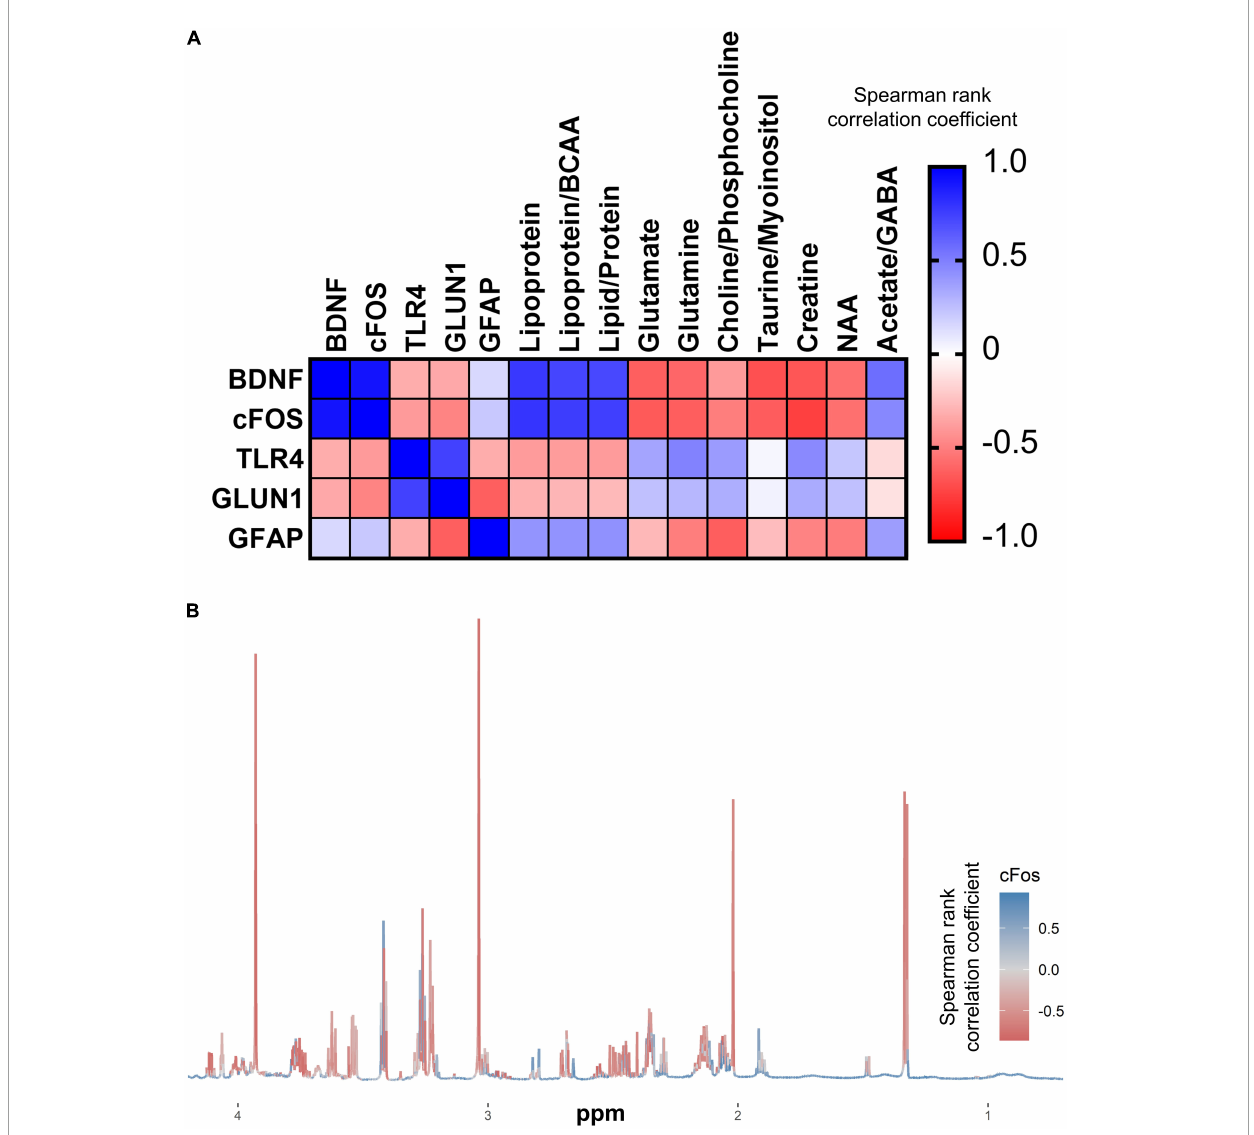
FIGURE8 cFOS expression is intimately linked to cerebral metabolism. (A) Correlation matrix of qPCR gene expression in the PFC with cerebral metabolites that were significantly altered in GF ( n = 6) vs. SPF ( n = 6) mice. (B) Median NMR spectrum ( n = 12) of the brain metabolome, colored by correlation with PFC cFOS